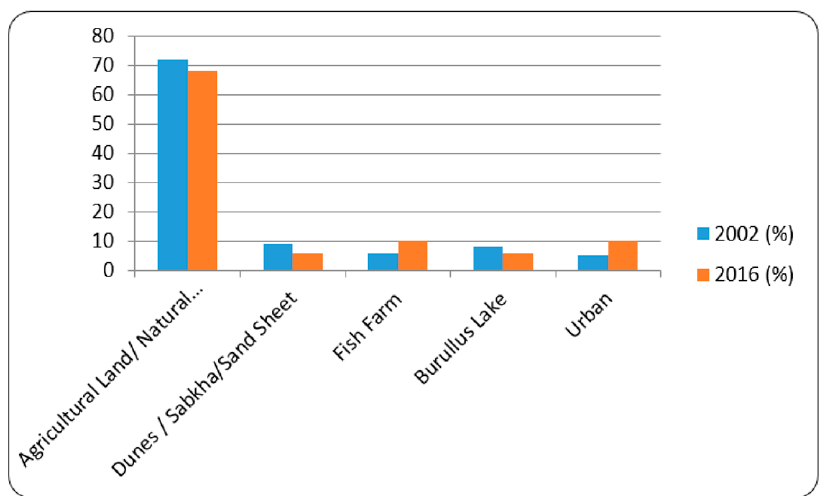
Figure 5. The percentage for each LULC class from 2002 and 2016.